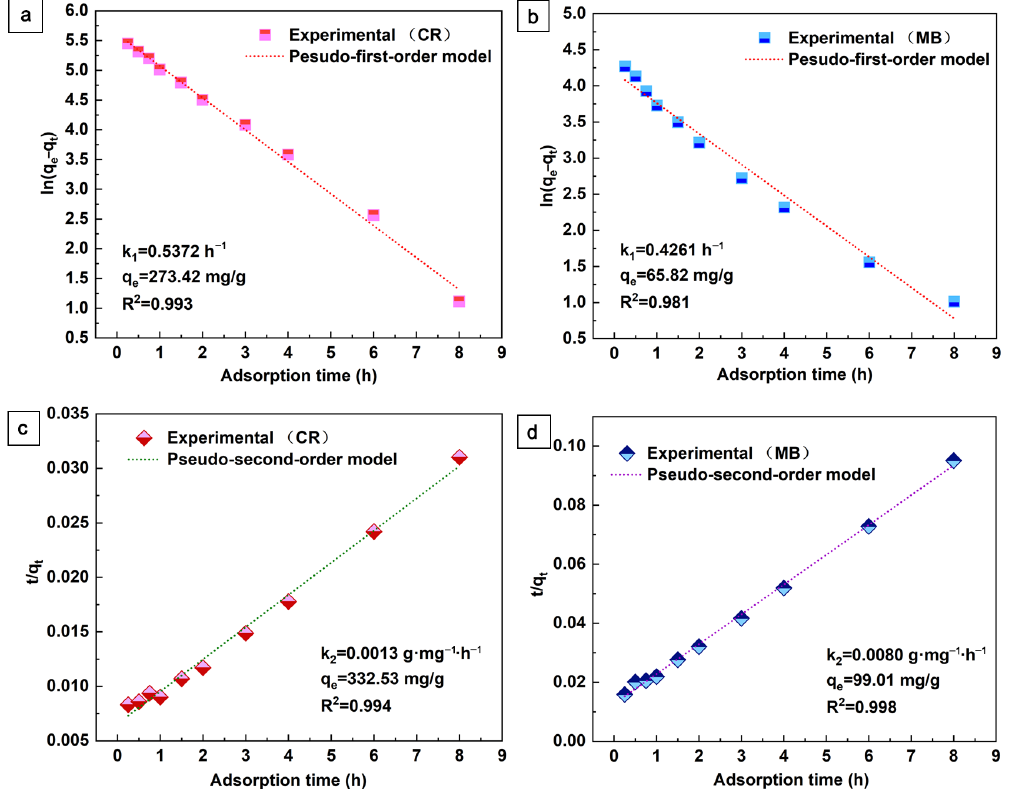
Figure 6. Pseudo-first-order and pseudo-second-order kinetic models for the adsorption of CR ( a , c ) and MB ( b , d ) on the aerogel.